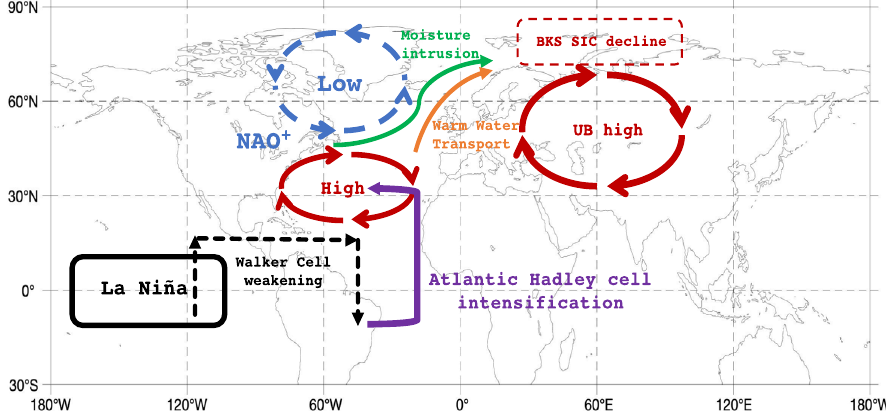
Fig. 8 | The pathway of El Niño-Southern Oscillation (ENSO) leading to the interannual variability of Barents-Kara sea-ice. Schematic diagram of La Niña (blackbox)in fl uencingthedeclineofseaiceconcentration(SIC)overBarents-Kara Seas(BKS)(dashedredbox)viathetransportofAtlanticwarmwaterasdenotedby theAtlanticoceanheattransport(orangeredline)andintrusionofwarmandmoist air (green line) into the BKS. The enhanced northward water transport and air intrusion are related to the positive phase of Atlantic interannual variability (AIV) and the positive North Atlantic Oscillation (NAO + )-like anomaly pattern with the Ural blocking (UB) high (anticyclonic red line over Eurasia) related to intensi fi ed